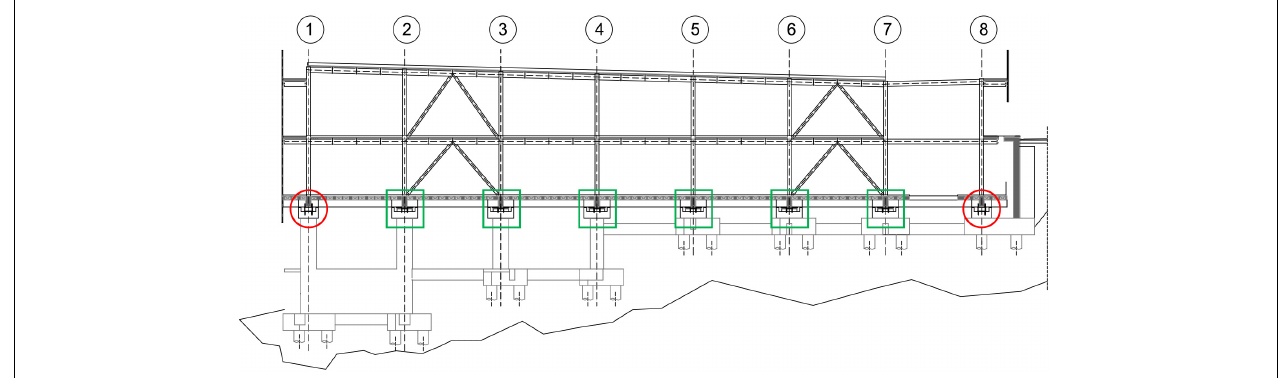
FIGURE 1 | Longitudinal section of the building (red circles represent HDR bearings and green squares represent flat sliders).